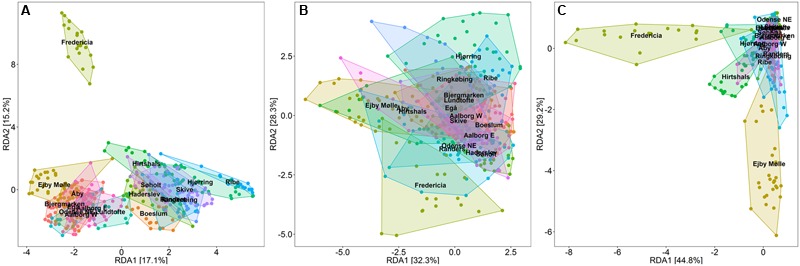
Redundancy analysis (RDA) plots, constrained to visualize the variance in OTU abundance, explained by sample plant origin. Axes show the percent of the total variation described by each principal component. (A) RDA plot of the overall bacterial community of 18 Danish full-scale EBPR WWTPs over a period of 9 years showing profiles of each plant. (B) RDA plot of the PAO part of the community showing similar community composition across the WWTPs, and (C) GAO part of the community showing dissimilarities among the WWTPs with several unique plant profiles.